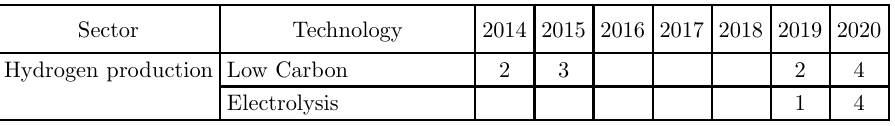
Patent registrations in technology of fuel cells and hydrogen production